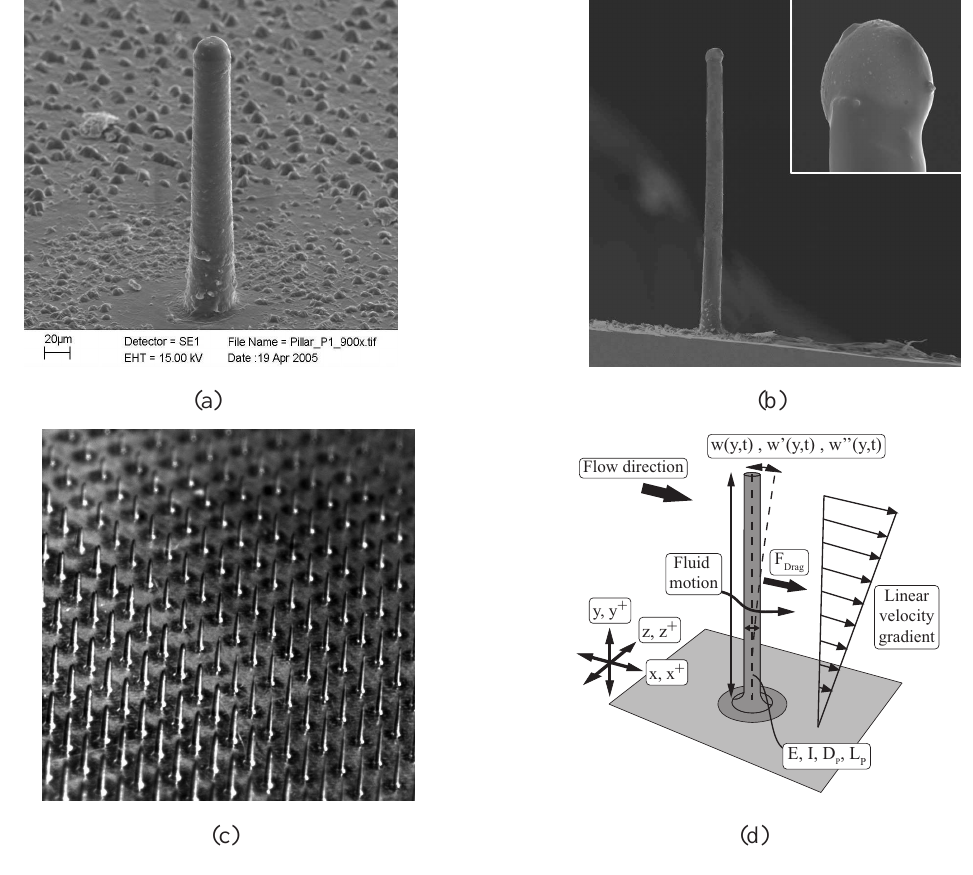
Figure 1. ( a , b ) Scanning-Electron Microscope (SEM) images of single pillars and ( c ) image of a pillar array. ( d ) Mechanical model of the pillar